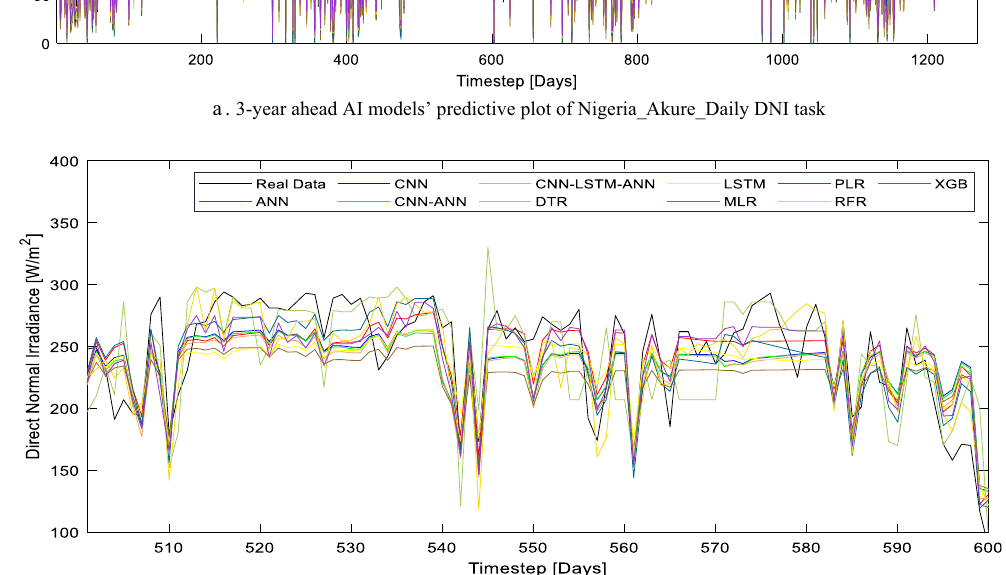
Figure 9. ( a ) 3-year ahead AI models’ predictive plot of Nigeria_Akure_Daily DNI task. ( b ) Nigeria_Akure_ Daily_DNI task day-ahead AI models’ predictive plot for